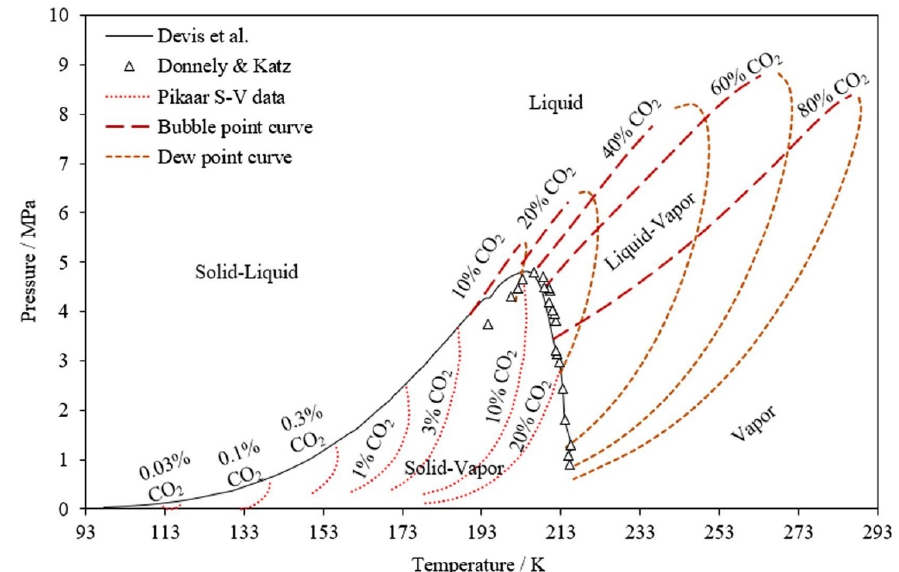
Figure 2. Effect of CO 2 concentration on P–T conditions [7] “Reprinted from Cryogenics, Vol 102, Babar, et al., Thermodynamic data for cryogenic carbon dioxide capture from natural gas: A review, Page 88, Copyright (2021), with permission from Elsevier”.